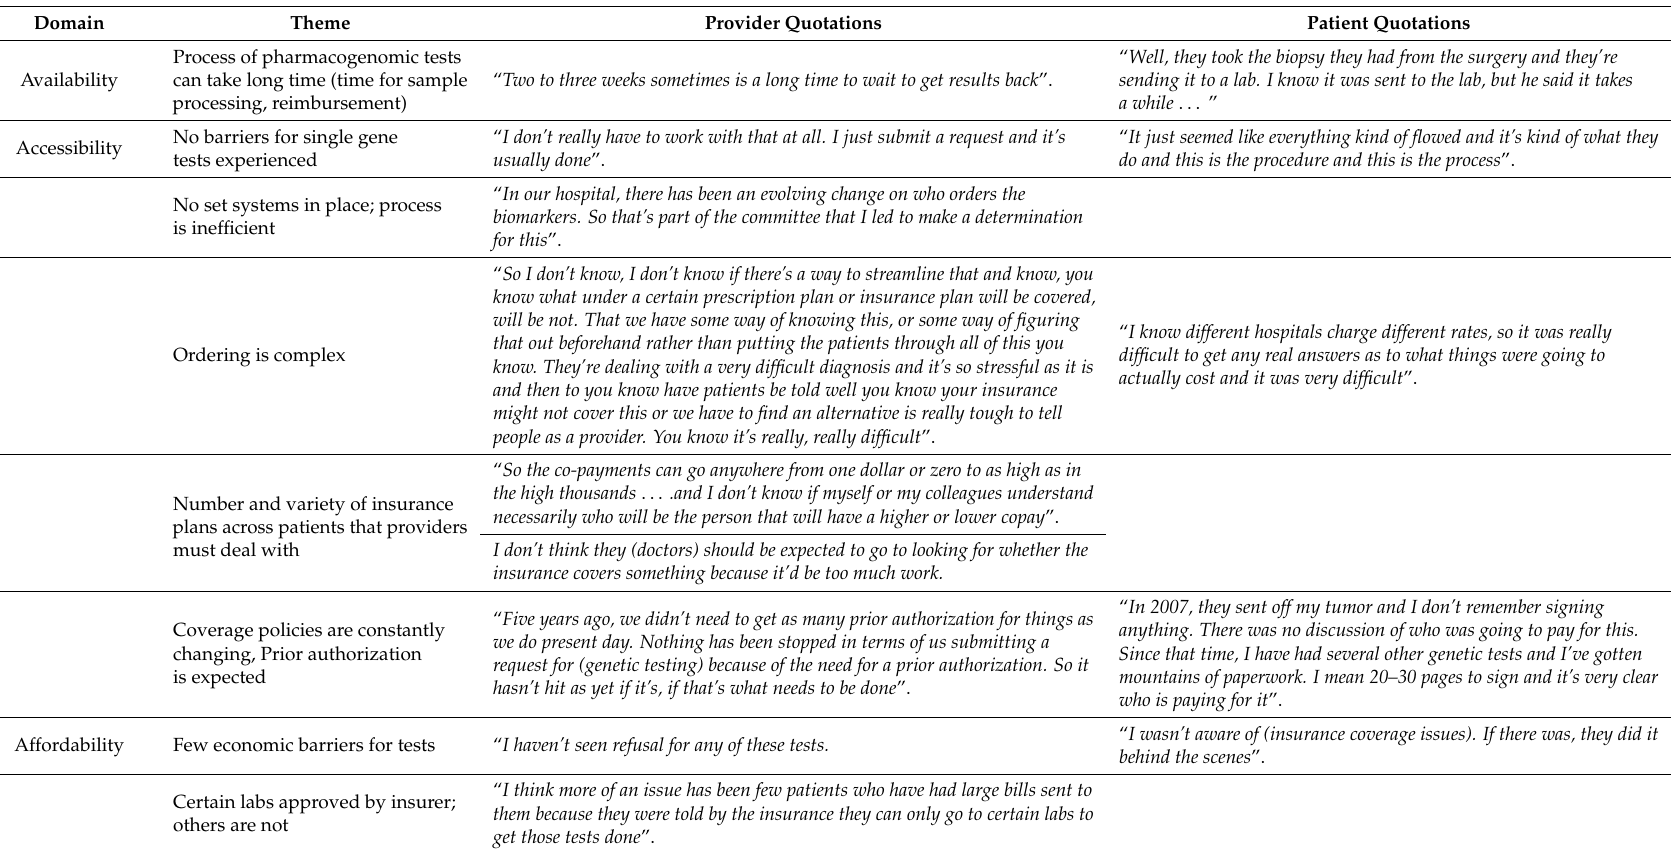
Table 3. Themes and quotations of provider and patient